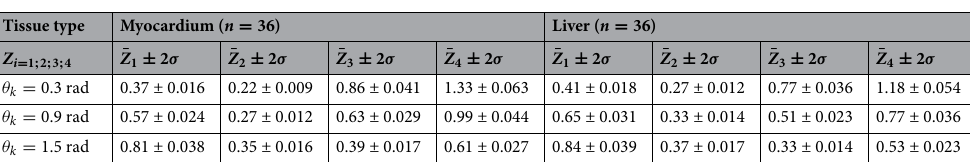
Table 1. Mean statistical moments of sets of layered depolarisation maps of histological sections of the myocardium and liver.